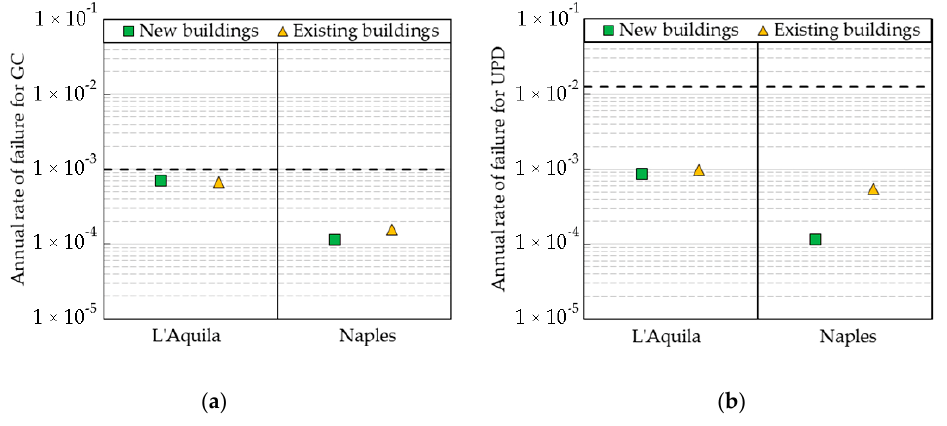
Figure 17. Annual rates of failure for the analysed base-isolated case studies, for the GC ( a ) and the UPD ( b ) performance levels.